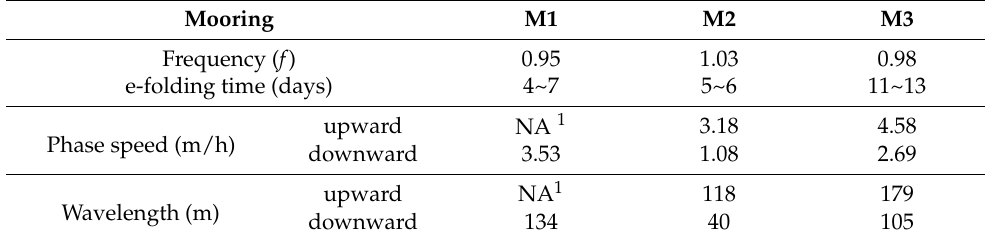
Table 2. Parameters of the observed NIWs in M1, M2, and